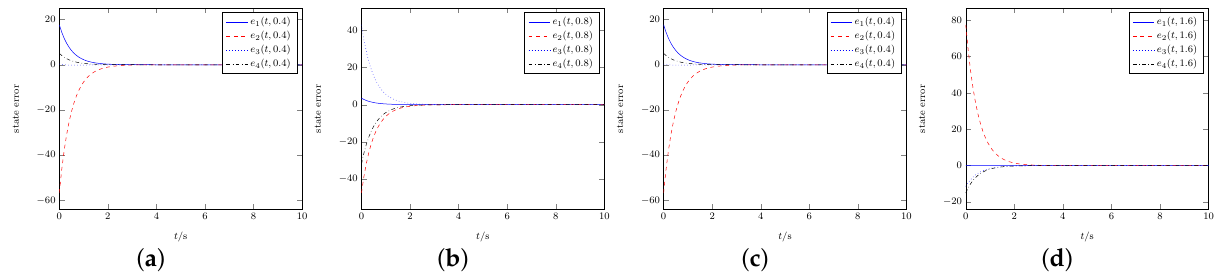
Figure 4. The evolution of estimation error states on four different locations. ( a ) z = 0.4. ( b ) z = 0.8. ( c ) z = 1.2. ( d ) z =